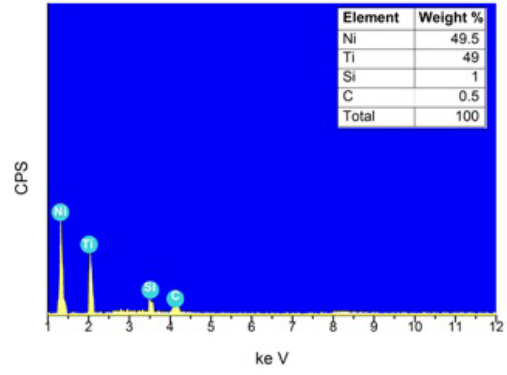
Figure 4. EDS for the microwave Nitinol sintered sample.